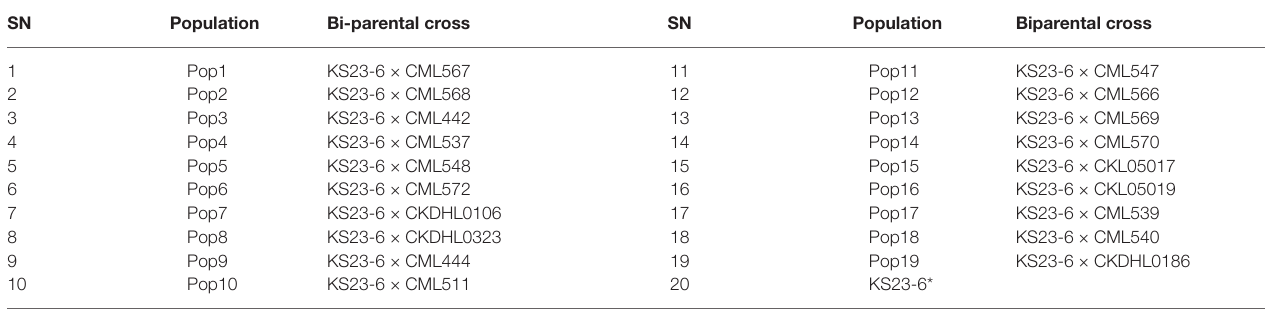
TABLE 1 | List of 19 bi-parental crosses generated and used to develop BC 3 F 2 lines genotyped for resistance to MLN using two polymorphic SNP markers linked to major QTL for resistance to MLN in BecA-ILRI Hub Lab in July 2017. SN Population Bi-parental cross